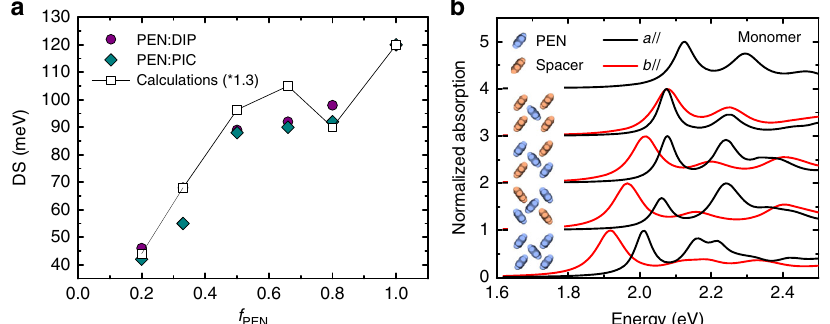
Fig. 3 Effects of incorporation of spacer molecules on Davydov splitting. a Davydov splitting (DS) of the lowest electronic excitation in PEN in PEN:DIP (purple circles) and PEN:PIC (green diamonds). For comparison, the DS resulting from calculations based on the lattice parameters of PEN:DIP (white squares), which has been scaled by a factor of 1.3 in order to match the experimental results at f PEN = 1, is also shown. b Comparison of the absorption spectrum of PEN if nearest neighbors (blue) are replaced by a spacer molecule (orange). In the mixed lattices f PEN = 0.5 and periodicity is maintained. The components of the spectrum polarized along a and b are normalized by the absorption maximum DS, shown as circles and diamonds for PEN:DIP and PEN:PIC,